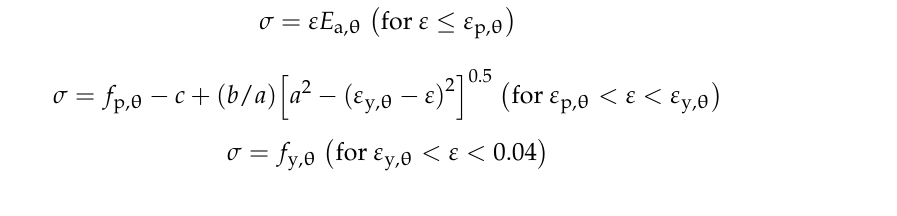
grade S275JR S275JR [19].